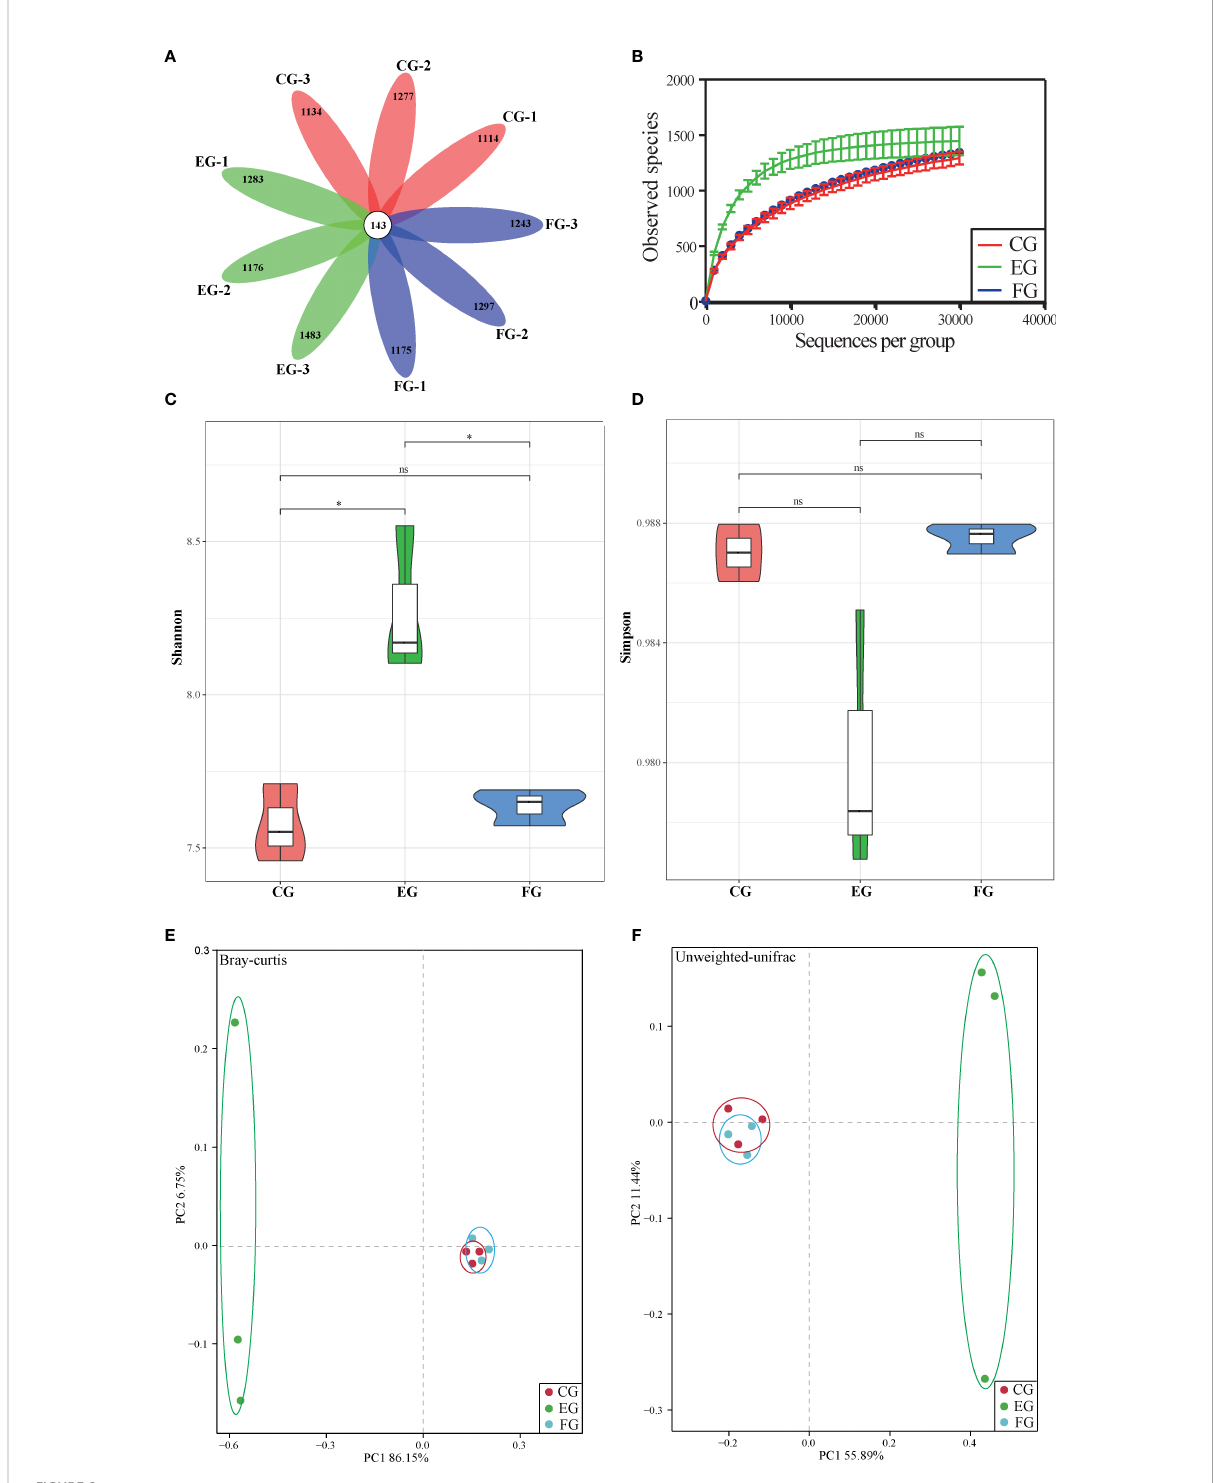
FIGURE 2 Alpha-diversity and beta-diversity of midgut bacterial community of grass carp with different diets (control group (CG), enro fl oxacin group (EG) and fl orfenicol group (FG)). (A) Venn diagram of shared and unique OTU numbers per sample. (B) Rarefaction curves of OTUs clustered at 97% sequence similarity across different groups. Bars show the mean ± SE (n=3). The different symbols represent signi fi cant differences (*, p < 0.05; ns, no signi fi cant). (C) Shannon-Wiener (Shannon) index. (D) Simpson index. (D – E) PCoA of the samples among different treatments ((control, enro fl oxacin and fl orfenicol) using bray-Curtis and unweighted-unifrac